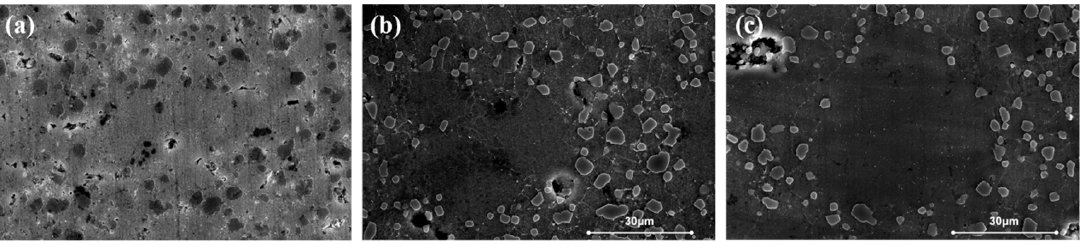
Figure 4. Microstructures of Al-7%Si-0.3%Mg-0.3%Cr alloy aged at 175 ℃ for ( a )1 h, ( b )6 h, ( c )12 h.